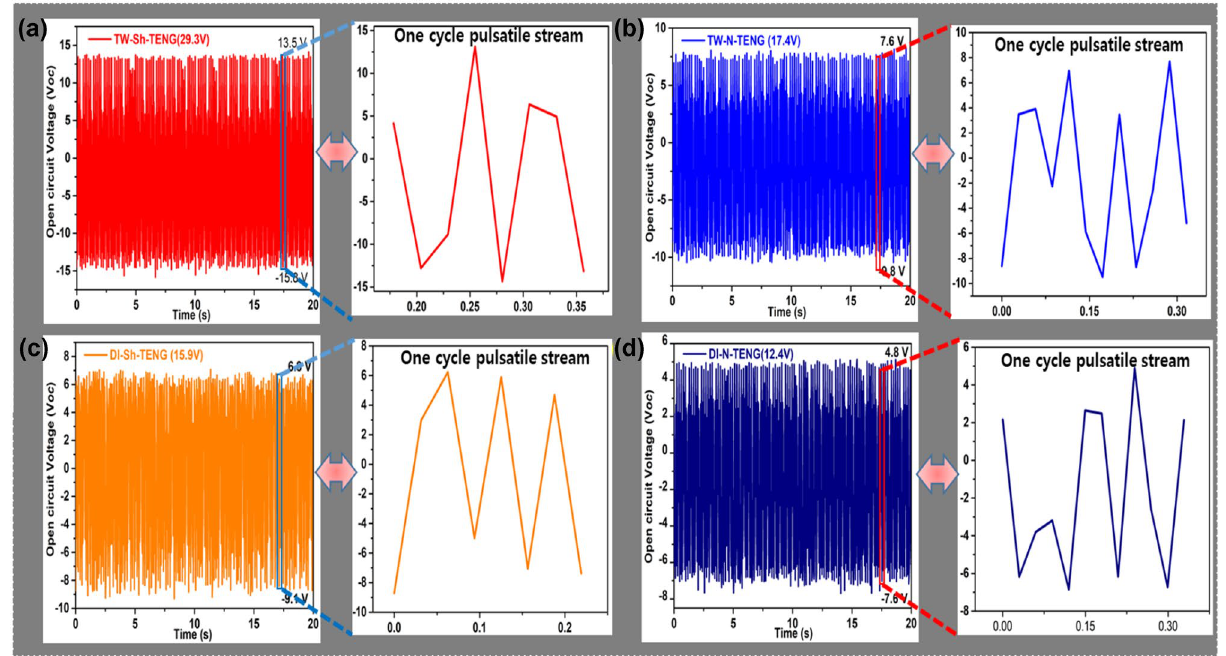
Figure 7. The open-circuit voltages (V oc ) of ( a ) TW-Sh-TENG; ( b ) TW-N-TENG; ( c ) DI-Sh-TENG; ( d ) DI-N- TENG and their single to three pulsatile open-circuit voltages (V oc ) showed in the inset images.